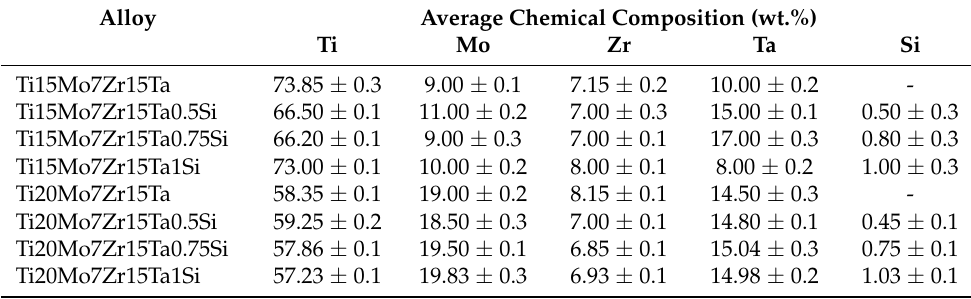
Table 2. Chemical composition for Ti-Mo-Zr-Ta alloys obtained. Alloy